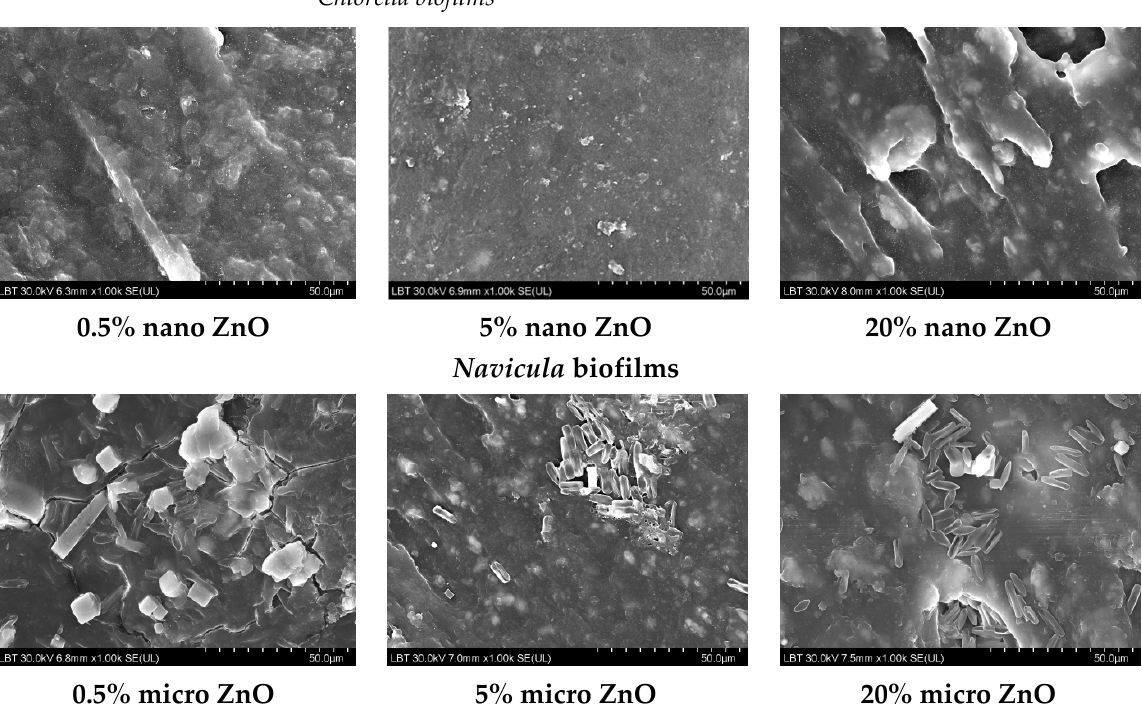
Figure 12. SEM images of Chlorella and Navicula biofilms on the 0.5%, 5% and 20% nano- and micro-ZnO-ABS 3D printed composites, respectively.